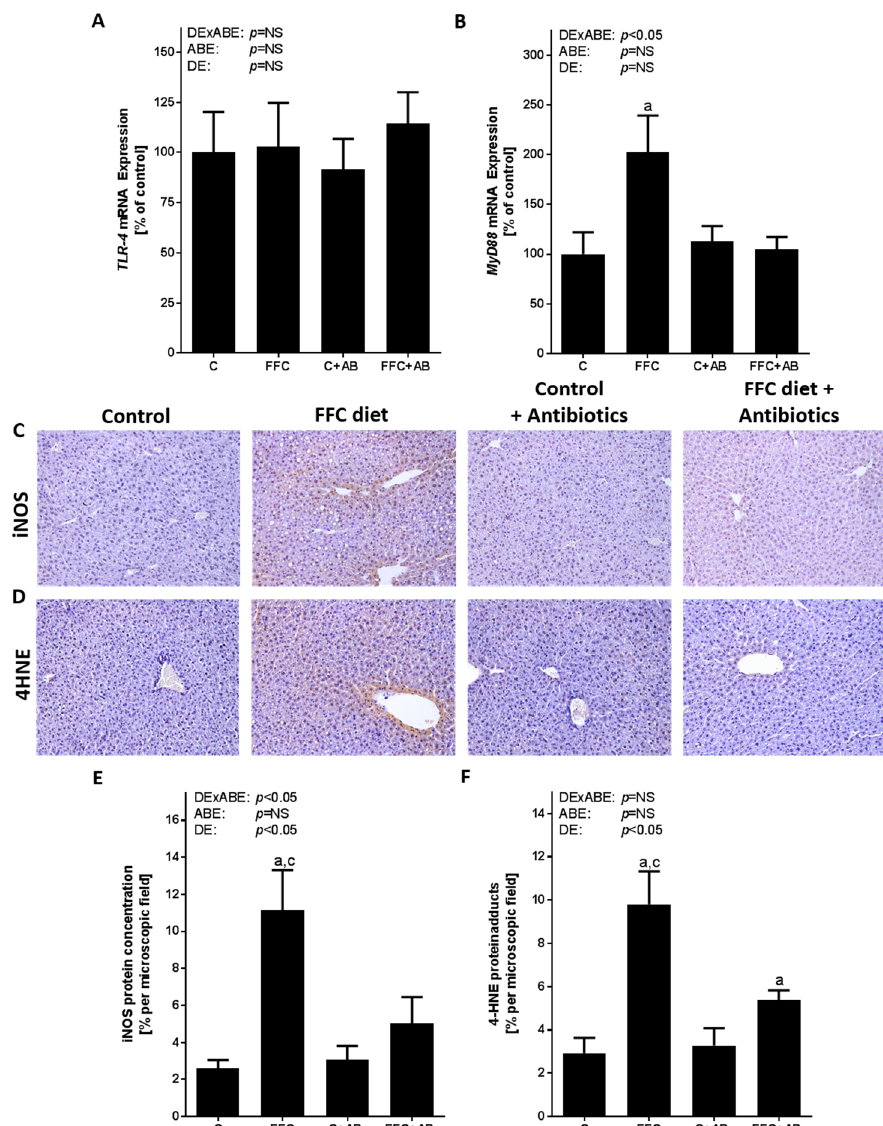
Figure 3. Effect of the short-term feeding of a FFC or control diet ± oral antibiotic treatment on markers of TLR-4 signaling cascade and lipidperoxidation in liver tissue. ( A ) TLR-4 and ( B ) MyD88 mRNA expression in liver tissue; ( C , D ) Representative pictures (200 × ) and ( E , F ) densitometric analysis of iNOS and 4-HNE protein adduct staining in liver tissue. 4-HNE: 4-hydroxynonenal; ABE: antibiotic effect; C: control diet; C + AB: control diet and oral treatment with antibiotics; DE: diet effect, DE × ABE: interaction between diet and antibiotics; FFC: fat-, fructose- and cholesterol-rich diet; FFC + AB: fat-, fructose- and cholesterol-rich diet and oral treatment with antibiotics; iNOS: inducible nitric oxide synthase; MyD88: myeloid differentiation primary response gene 88; NS: not significant; TLR-4: toll-like receptor-4. a p < 0.05 compared with mice fed a control diet; c p < 0.05 compared with mice fed a control diet treated with antibiotics.